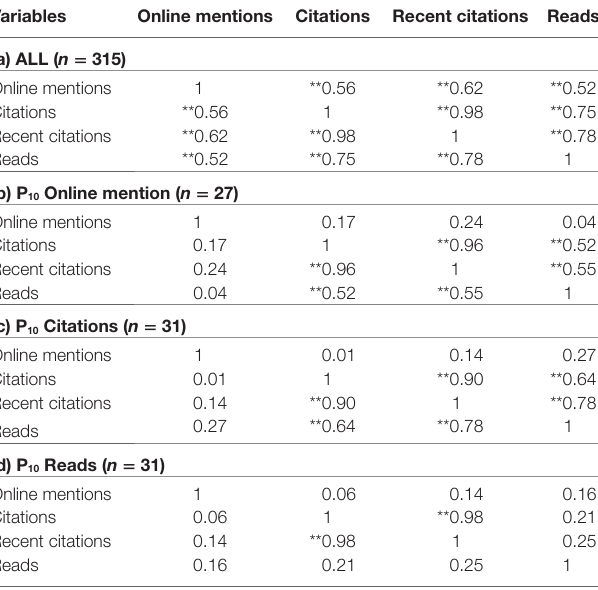
TaBle 3 | Correlation matrix between author-level metrics: (a) all authors; (b) top authors according to Online mentions received; (c) top authors according to Citations received; (d) top authors according to Reads